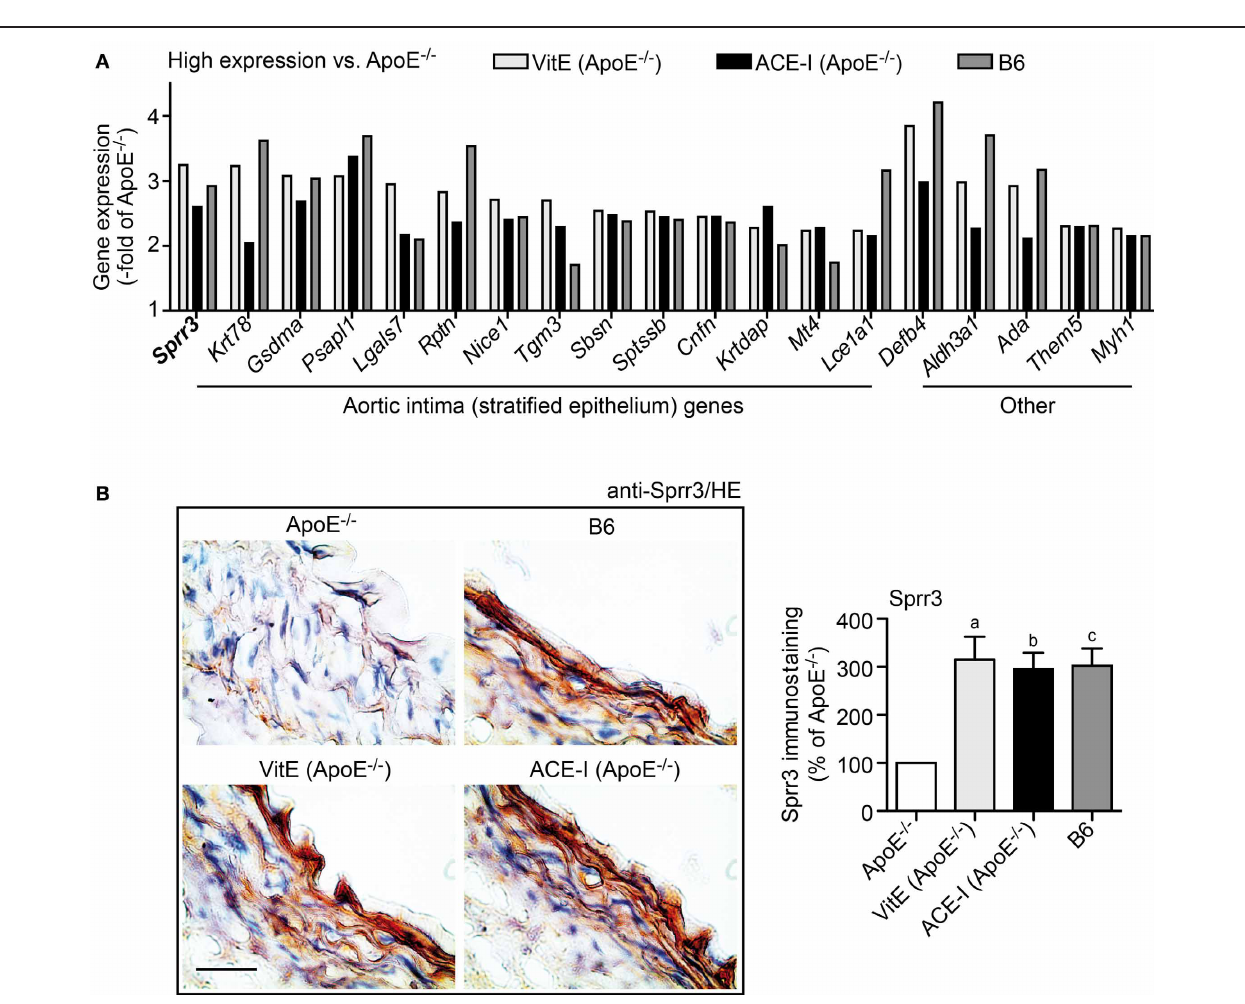
FIGURE 4 | Vitamin E and ACE-inhibitor treatment maintained the integrity of aortic intima genes of atherosclerosis-prone ApoE − / − mice. (A) Microarray gene expression data of concordantly regulated genes with high expression in vitamin E-treated (VitE) and ACE-inhibitor treated (ACE-I) ApoE − / − aortas relative to untreated ApoE − / − mice ( ≥ 2-fold higher signal intensity; P ≤ 0 . 01) and normalization toward B6 control level. GO analysis classified the majority of those genes with high expression as stratified epithelial genes of the aortic intima, which could preserve the biomechanical barrier function of the aortic intima. Relative gene expression of concordantly regulated genes is presented